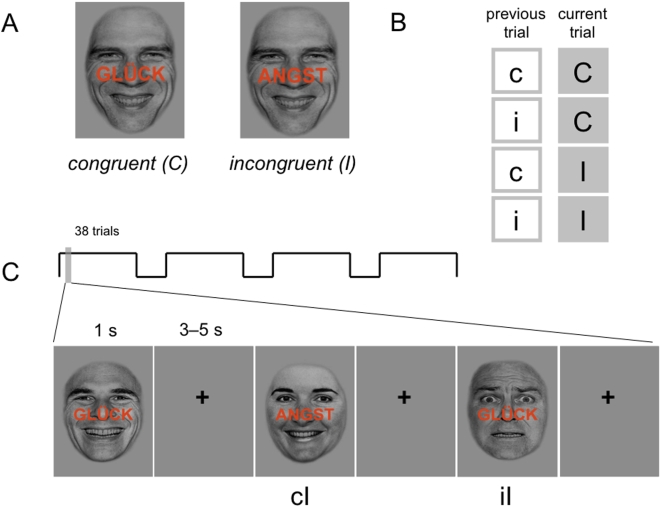
Emotional conflict paradigm.(A) Basic stimulus material consisting of congruent and incongruent face expression/word pairs from eight subjects of the Ekman faces collection (fearful and happy face expression; words ‘happy’ and ‘fear’)[42]. (B) Categorization of trials into four order types (cC, iC, cI, iI) depending on congruence of the previous and the current trial. (C) Each 38 randomized stimuli were presented in four blocks (see methods section) with jittered interstimulus interval. The second trial in the depicted example would be classified as ‘cI’, and the third trial as ‘iI’, also referred to as low and high conflict resolution trials [32].